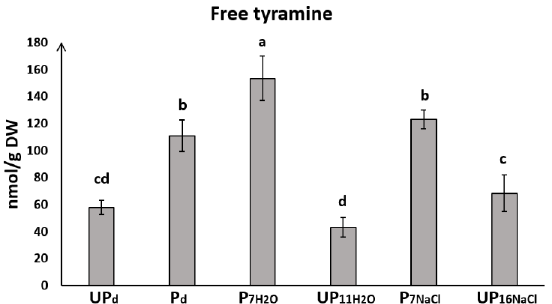
Figure 4. Concentration of free tyramine in the seeds of Brassica napus before the start of germination (dry unprimed seeds, UP d and primed dried seeds, P d ) as well as during germination (primed seeds germinating for 7 h in water, P 7H 2 O ; unprimed seeds germinating for 11 h in water, UP 11H 2 O ; primed seeds germinating for 7 h in NaCl, P 7NaCl ; unprimed seeds germinating for 16 h in NaCl, UP 16NaCl ). The differences were statistically significant, as determined by one-way analysis of variance (ANOVA) and Tukey–Kramer multiple comparison test ( n = 6, p < 0.05). The vertical bars denote SD. The same letters on bars describe not significant differences between means.